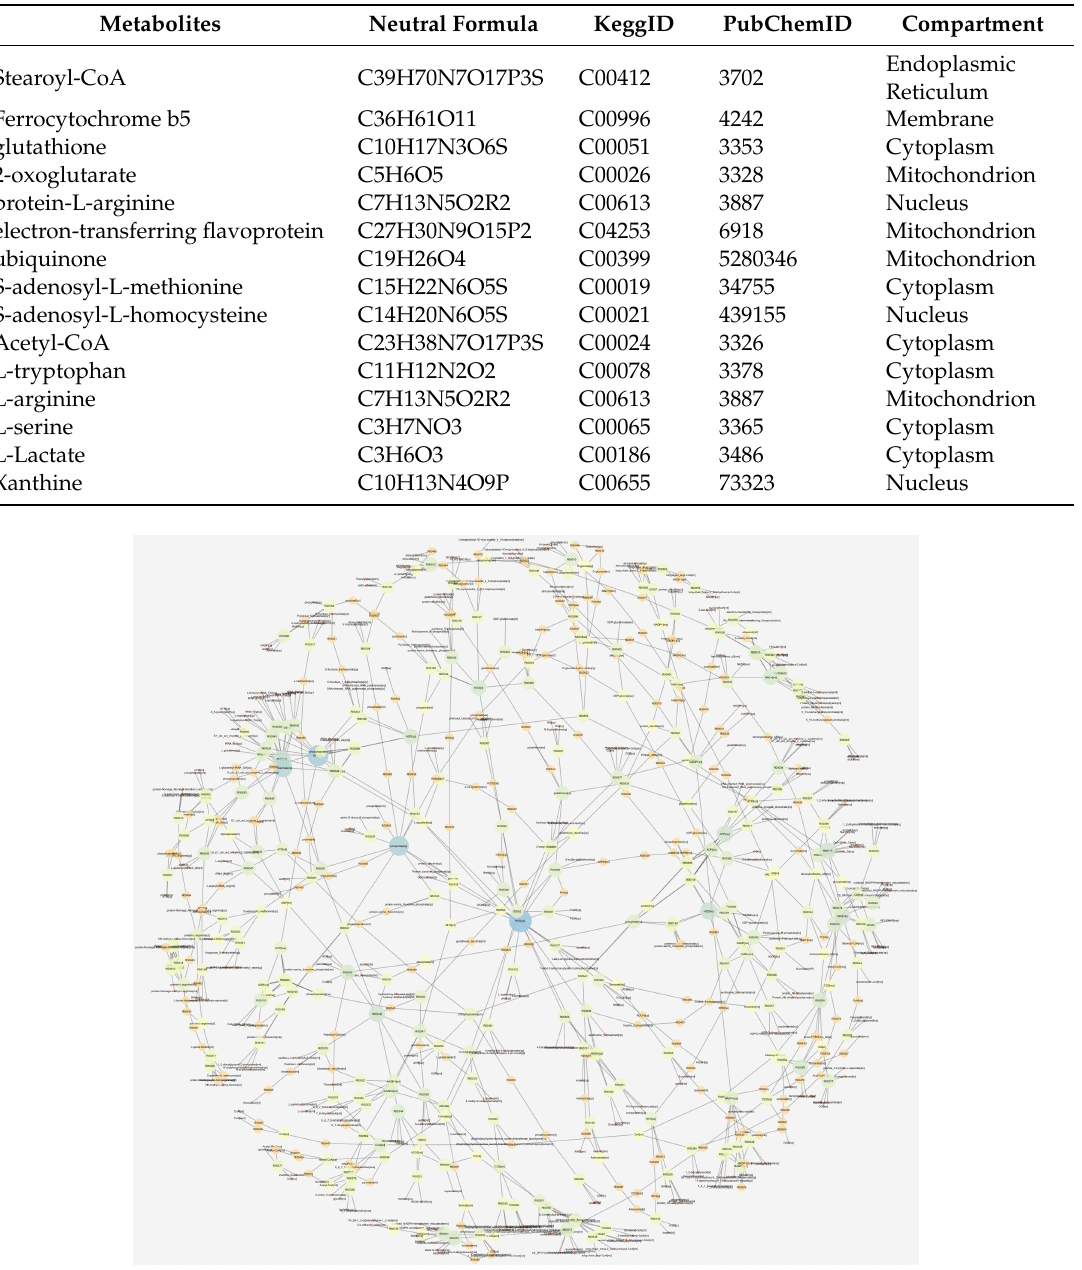
Figure 4. The reconstructed acidosis metabolic network for